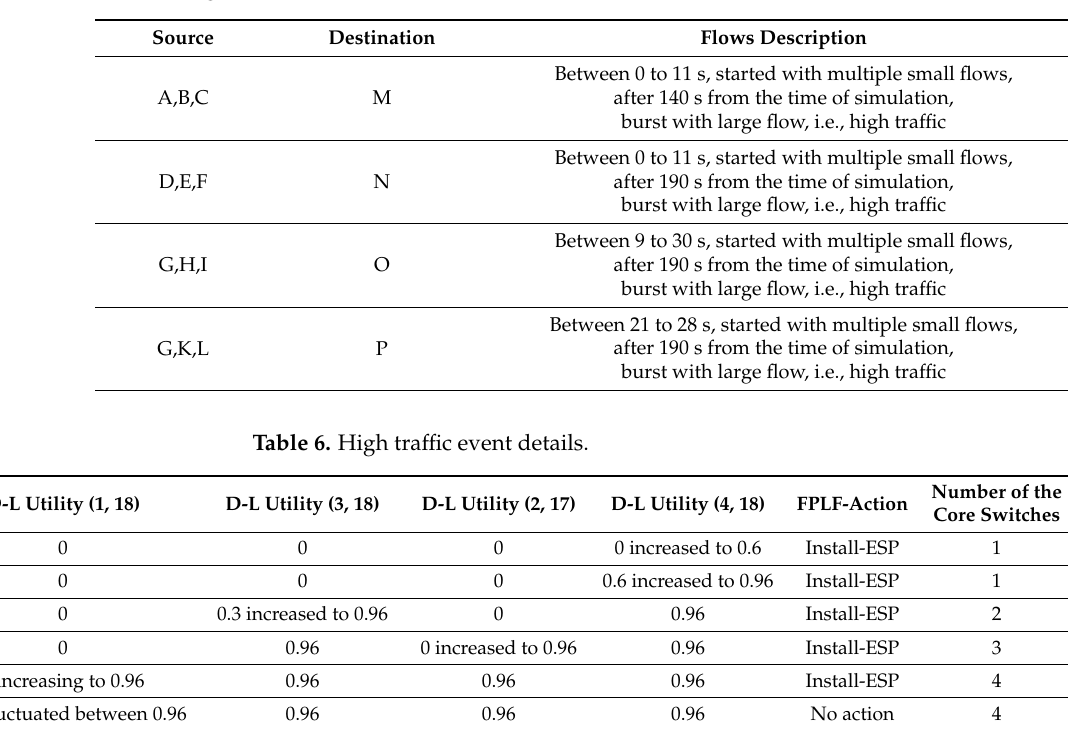
Table 5. High traffic flow details.